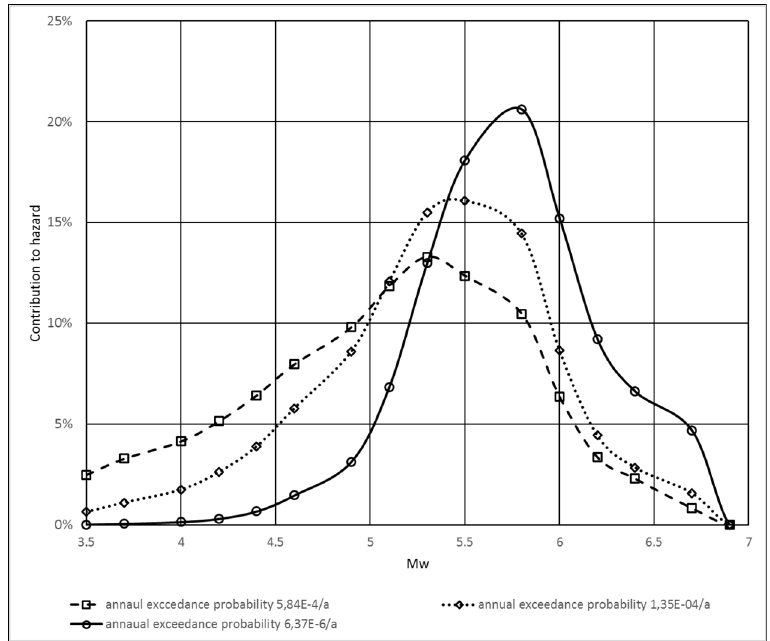
Figure 6. Contributions of different magnitudes to the seismic hazard.